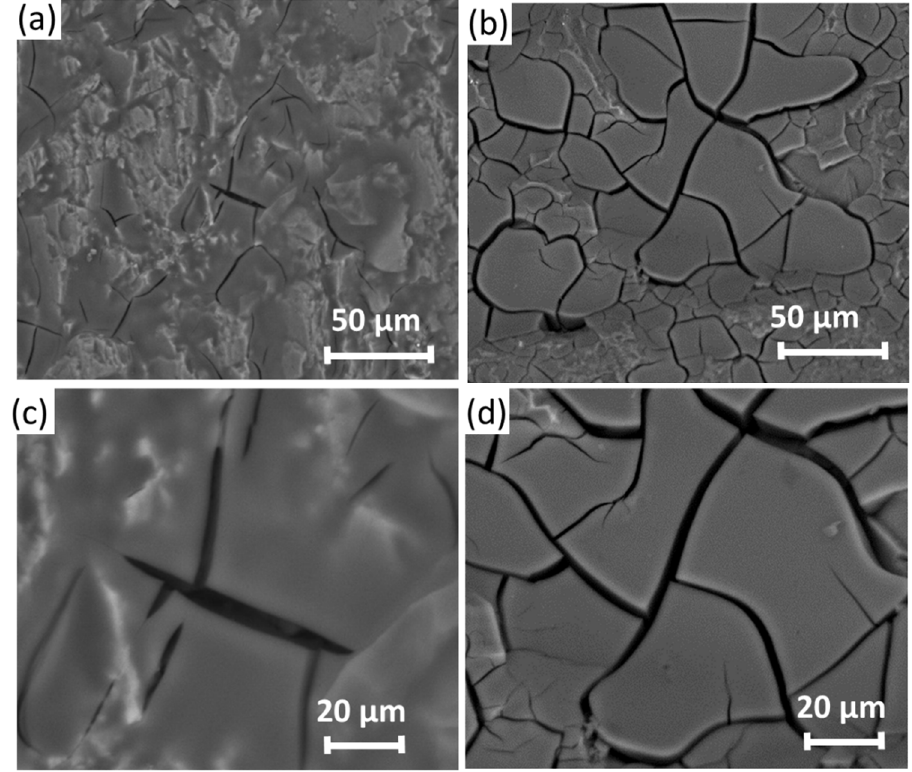
Figure 6. SEM micrographs of the surfaces treated only with the consolidant products. ( a , c ) Estel 1000. ( b , d ) Nano Estel.